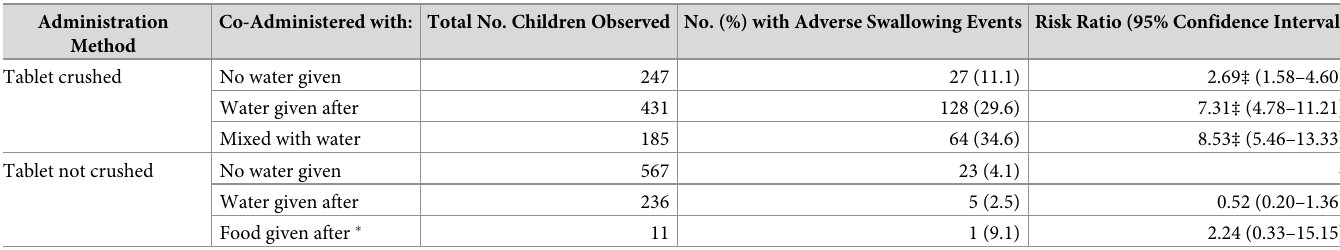
(‡ p-value < 0.001) (cid:3) The category “Food given after” included 11 children who received food (but not water) after being given a whole (non-crushed) tablet; in Tables 1, 4 and 5 these children were classified as not having received